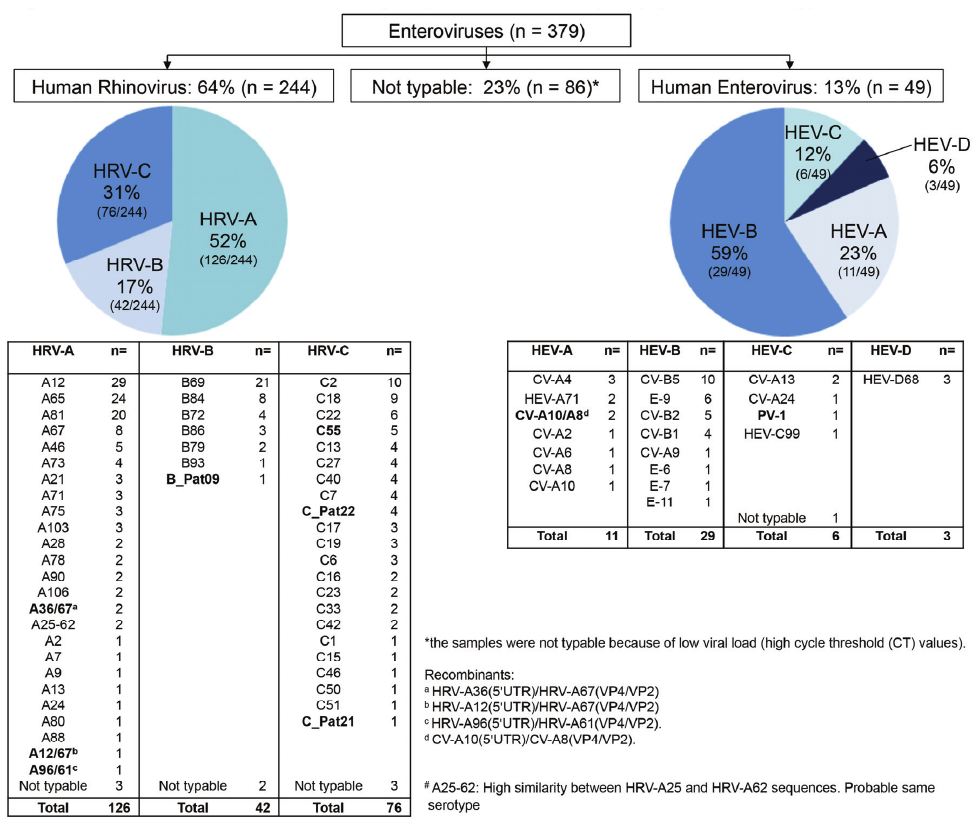
Figure 1. Distribution of human rhinoviruses (HRV) and enteroviruses (HEV) species and serotypes.